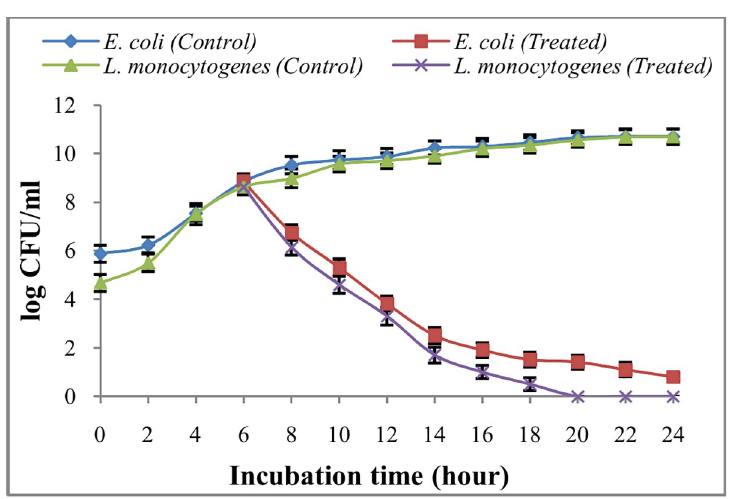
Fig 3. Mode of action of ethyl acetate fraction of AE1 on bacterial